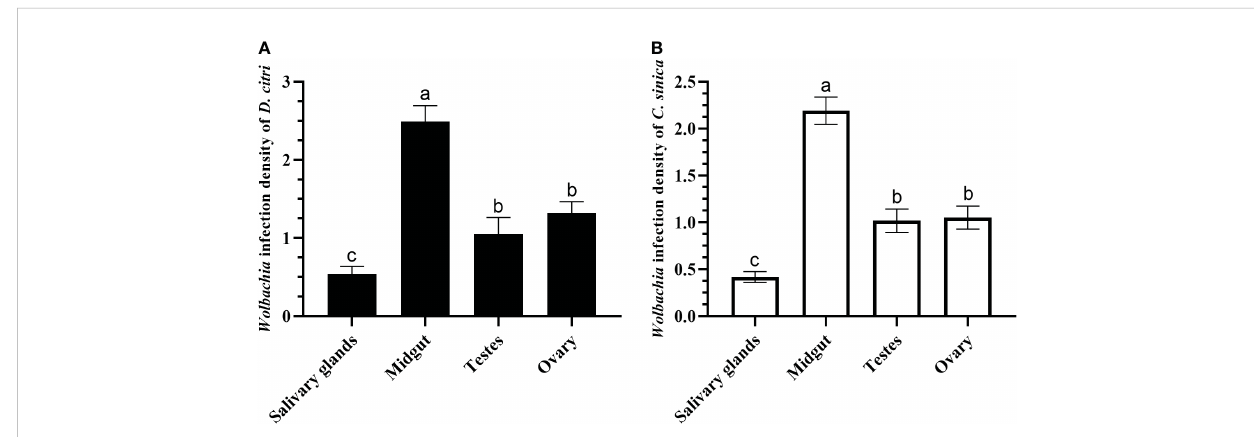
FIGURE 6 Wolbachia titers in salivary glands, midgut, testes, and ovary of Diaphorina citri (A) and Cornegenapsylla sinica (B) . Error bars indicate 95% con fi dence intervals. Different letters indicate signi fi cant differences among different tissues ( P < 0.05).